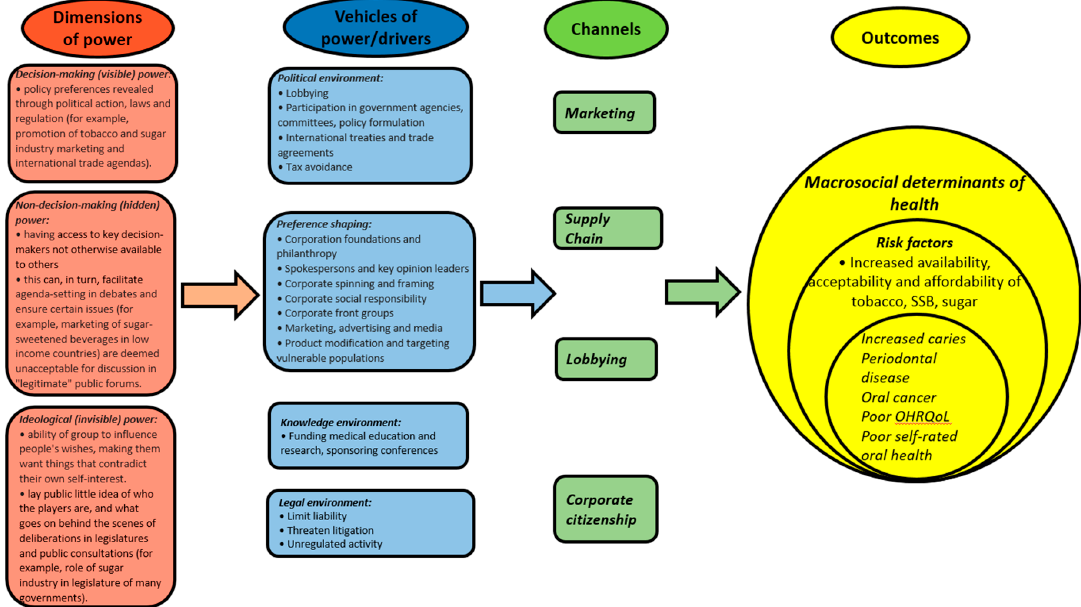
Figure 1. Conceptual framework of corporate determinants of health and oral health inequalities, based on Lukes’ three faces of power theory and Kickbusch’s processes through which transnational corporations exert influence.